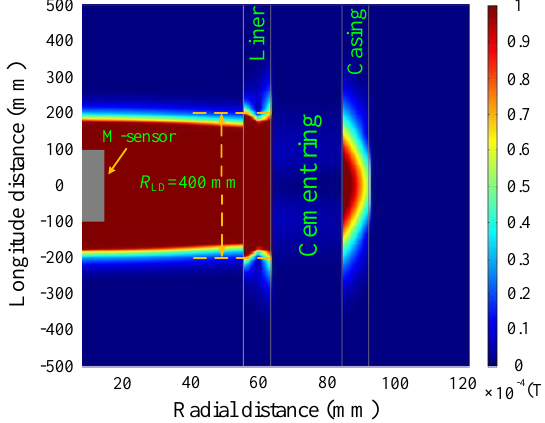
Figure 7. Eddy-current field of the main sensor at 20 ms. Sensors 2017 , 17 , 1836 Figure 8. Eddy-current field of the main sensor at 50 ms.